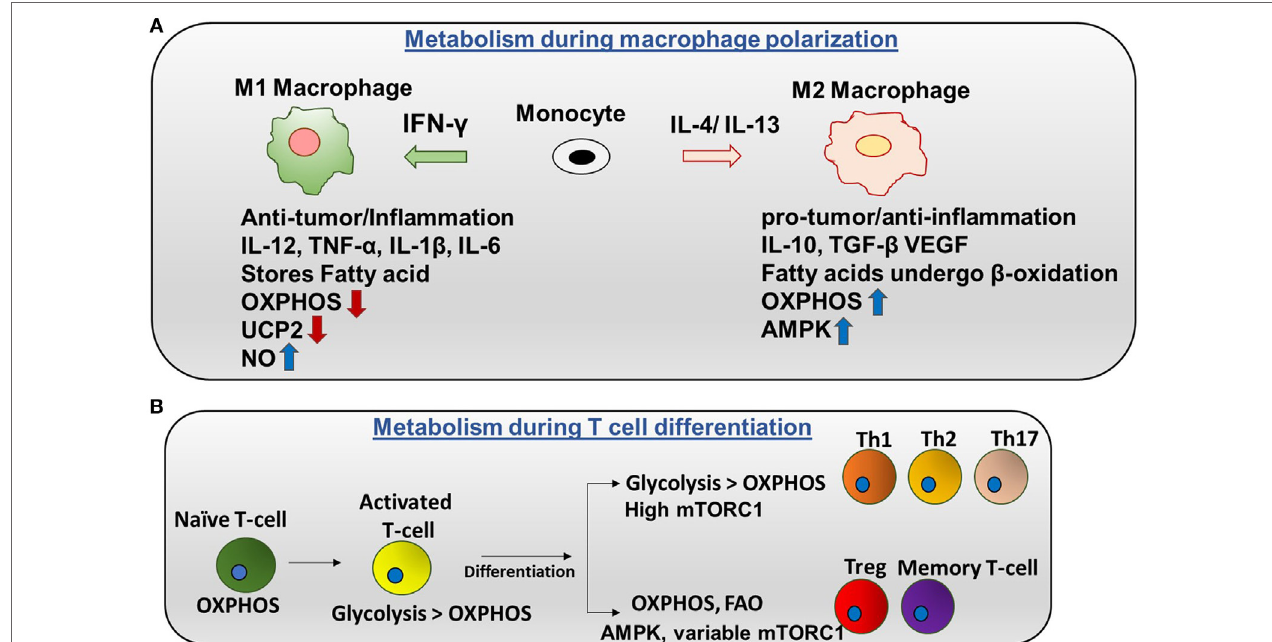
FiguRe 2 | Metabolic regulation in macrophages and T cells: (A) metabolism during macrophage polarization: polarization of monocytes to M1 or M2 phenotypes is controlled by the cytokines produced by other immune cells. M1 macrophages are activated by IFN- γ produced by Th1 cells. M1 macrophages tend to store surplus FA as triacyclglycerols and cholesteryl esters in lipid droplets, and they exhibit higher aerobic glycolysis and lower oxidative phosphorylation (OXPHOS). Nitric oxide production is higher in M1. Uncoupling protein 2 (UCP2) expression is decreased in M1 macrophages. Contrarily, M2 macrophages are activated by IL-4 or IL-13 to regulate anti-inflammation and promote Th2 response and tissue repair. M2 macrophages adopt a metabolic program dominated by fatty acid-fueled OXPHOS and channel FA toward re-esterification and β -oxidation. Silencing UCP2 impairs M2 macrophage activation by IL-4. High adenosine monophosphate- activated protein kinase (AMPK) and low NO is the reason for high OXPHOS in M2 macrophages. (B) Metabolism during T cells differentiation: naïve T cells are dependent on OXPHOS as their primary metabolic pathway. By contrast, activated T cells exhibit higher glycolysis than OXPHOS. After differentiation, Th1, Th2, and Th17 have higher glycolysis than OXPHOS and high mTORC1 activity. Memory T cells and regulatory T cells undergo AMPK-dependent FAO and have variable